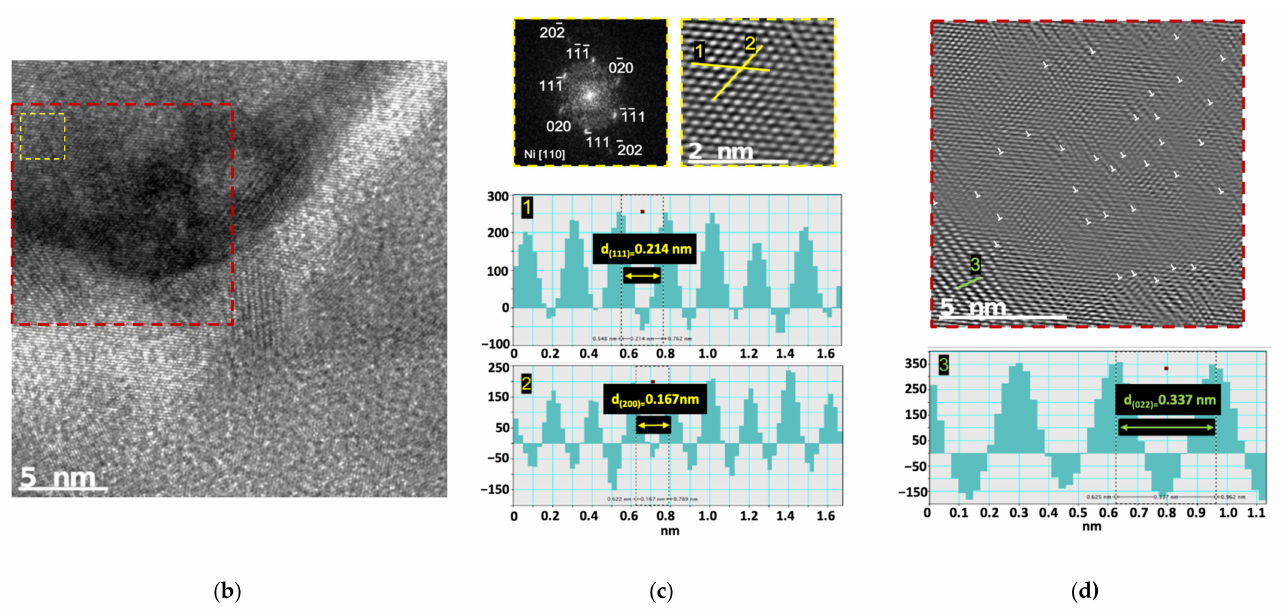
Figure 12. ( a ) TEM images showing dislocations and CNTs embedded, ( b ) HRTEM image of nanocomposite showing a region close to a CNT, ( c ) FFT, inverse FFT images and interplanar distance of the 1 and 2 lines profile, ( d ) inverse FFT of the marked red region showing the dislocations surrounding the CNT and interplanar distance of the 3 line profile. To understand the effect of the CNTs on the microstructure of the nanocomposites during sintering, GOS maps of the Ni and Ni-CNT produced with different ball milling times were obtained, as shown in Figure 13.